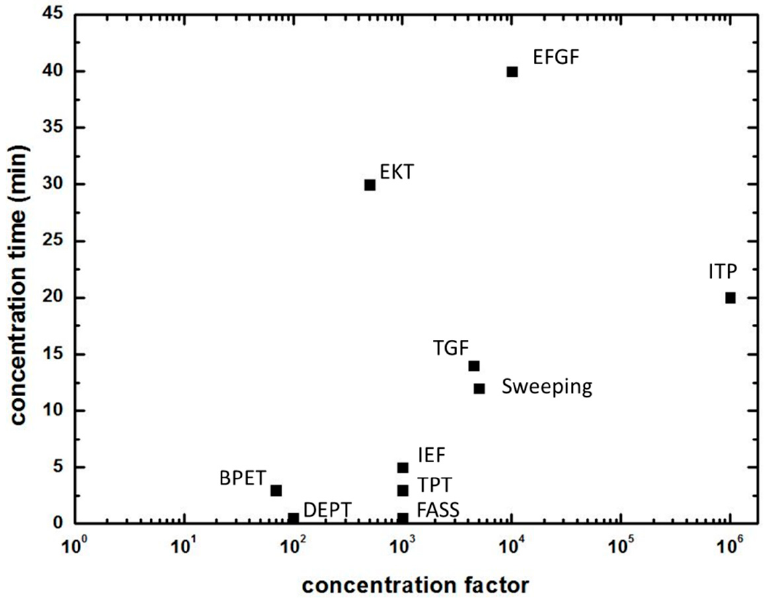
Figure 15. Concentration enhancement factor vs. concentration time for a variety of microfluidic sample concentration techniques. TGF, temperature gradient focusing (with Joule heating); IEF, Isoelectric focusing; EFGF, electric field gradient focusing; FASS, field amplified sample stacking; ITP, isotachophoresis; EKT, electrokinetic trapping; DEPT, dielectrophoretic trapping; TPT, thermophoretic trapping; BPET, bipolar electrode trapping.